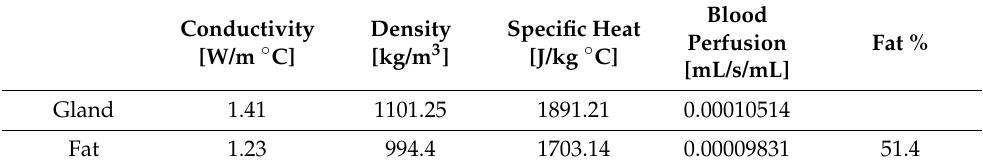
Table 11. Estimated specific breast parameters (patient #5).